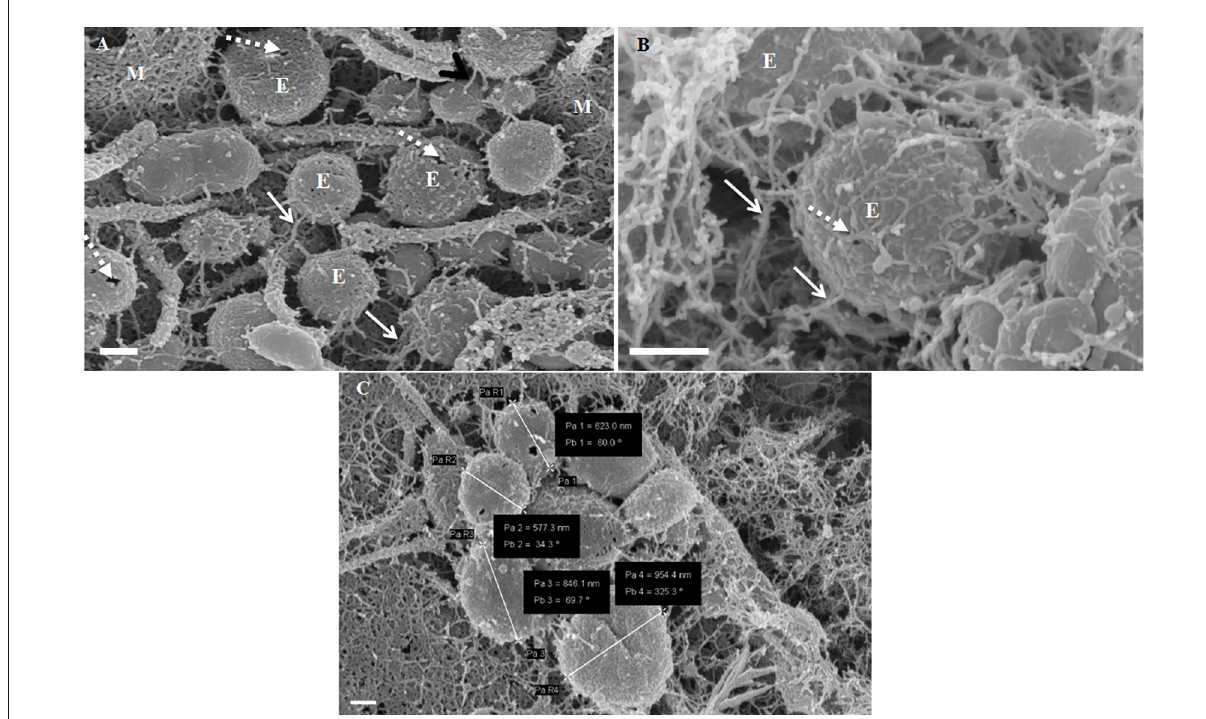
FIGURE3 The formation of NTF-exosomes, on the BEC plasma membrane surface. (A) The HR-SEM micrograph depicts exosomes emanating from the bEnd5 plasmalemma. Scale bar = 200 nm. (B) A magnified version of NTF-exosomes accrued on the bEnd5 plasmalemma. The perforated, white arrows indicate the porous NTF-exosome membrane structures. Scale Bar = 300 nm. The “sticky” short filaments of the membrane-bound exosome anchoring to the BEC membrane surface, are indicated by white solid arrows. M denotes the plasmalemma surface, and E denotes Non-TUNT-Forming-exosomes. (C) A heterogenous population of measured, BEC exosomal nanovesicles. Scale bar = 200